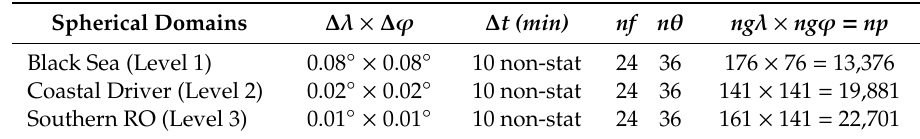
Figure 12. The computational domains defined in Simulating WAves Nearshore (SWAN) model simulations: ( a ) Level 1—Black Sea basin; Level 2 (right side)—western coastal driver. ( b ) Level 3—nearshore area in the southern Romanian nearshore. ( c ) Local site (Mangalia Port). Location of the nearshore target point (TP) and sector of wave directions considered OWC in the northern breakwater. Table 1. Characteristics of the computational domains defined in spherical coordinates for the SWAN model simulations focused on the western side of the Black Sea.